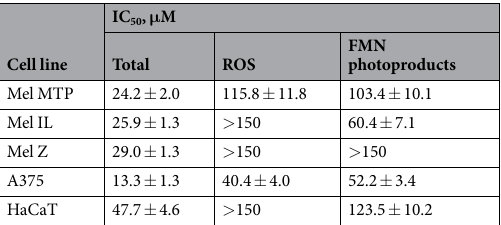
Table 1. IC 50 values for Mel Mtp, Mel IL, Mel Z, A375, and HaCaT cells after FMN photoactivation (450 nm, 5 J/cm 2 ). Cells without any treatment were used as